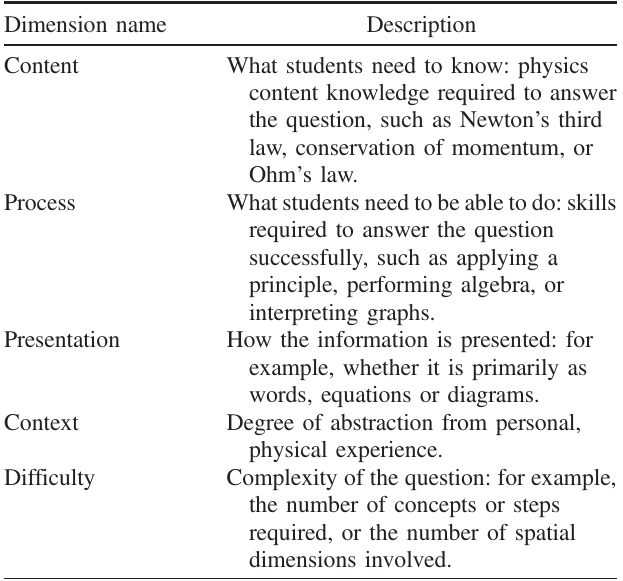
TABLE II. Dimensions used to describe the